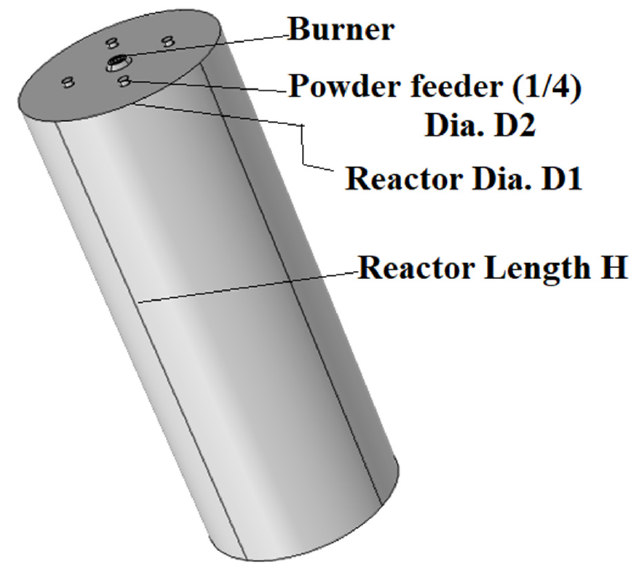
Figure 23. Schematic representation of the industrial reactor.